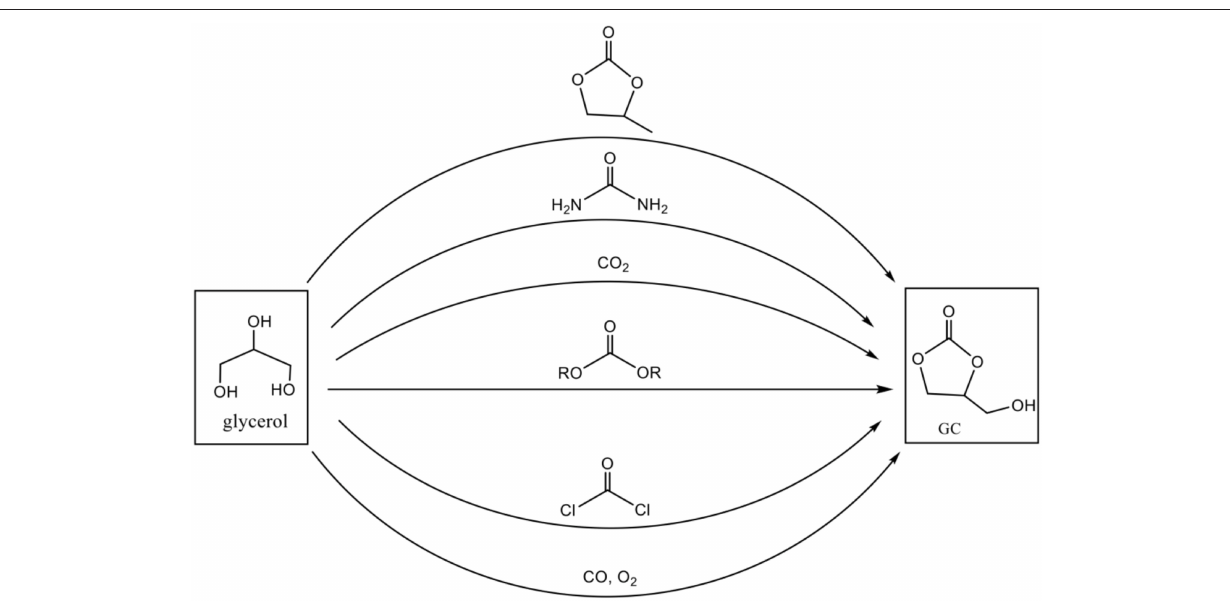
FIGURE 3 | Different conversion routes for synthesis of glycerol carbonate (adapted from reference Van Mileghem et al., 2018). diisoamyl carbonate (17.44 g, overall yield 76%) in the form of a colorless and odorless liquid. 1 H NMR (400 MHz, CDCl 3 ): δ (ppm) = 4.11–4.12 (t,